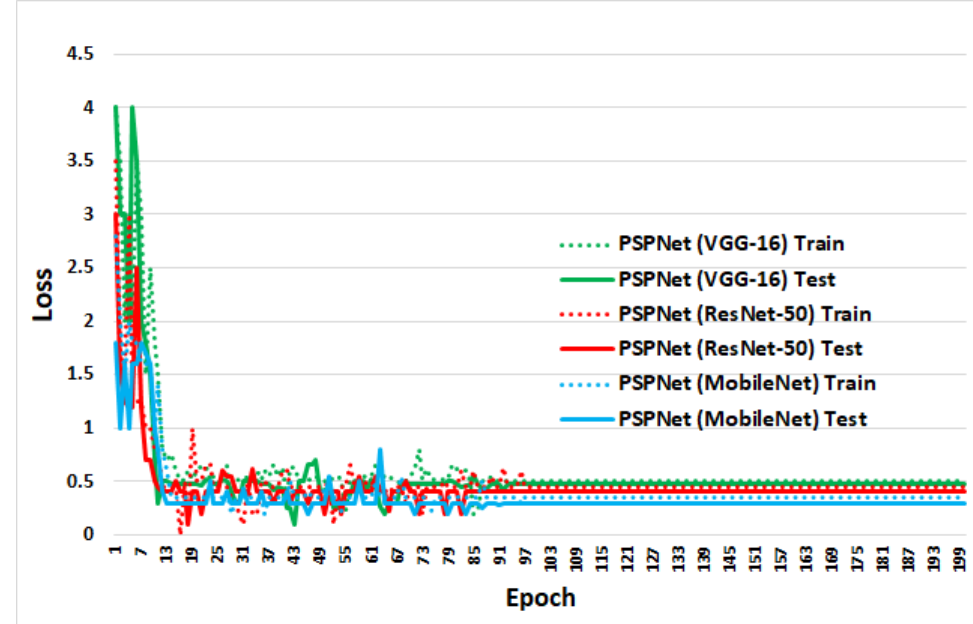
Figure 6. Train and Test Loss with CNN classification architectures.